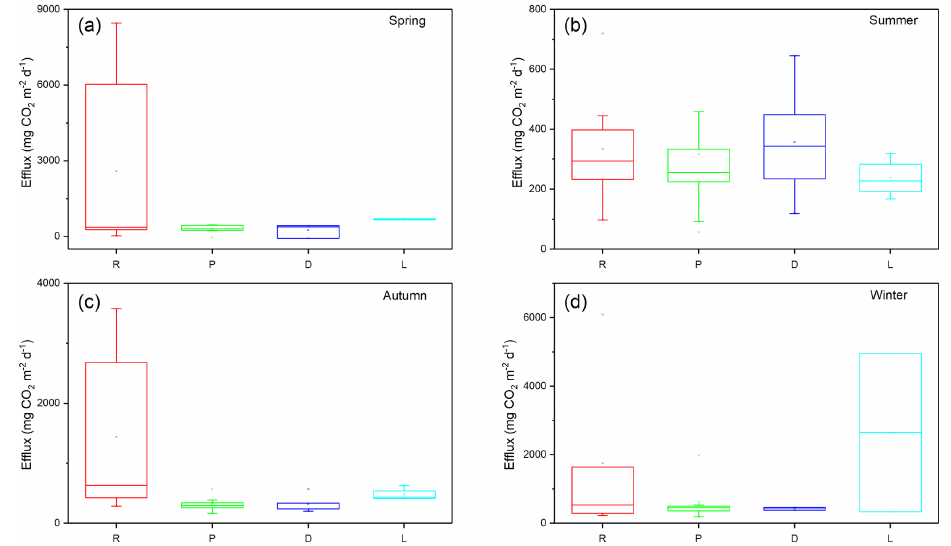
Figure 4. Box plots of the measured CO 2 effluxes in the spring (a) , summer (b) , autumn (c) and winter (d) . The lower and upper bounds of the box refer to the first and third quartiles, respectively, and the vertical line indicates the 1.5 interquartile range. The points outside the range are considered outliers and are represented by a small cross. The horizontal line refers to the median value while the small squares refer to the average values.